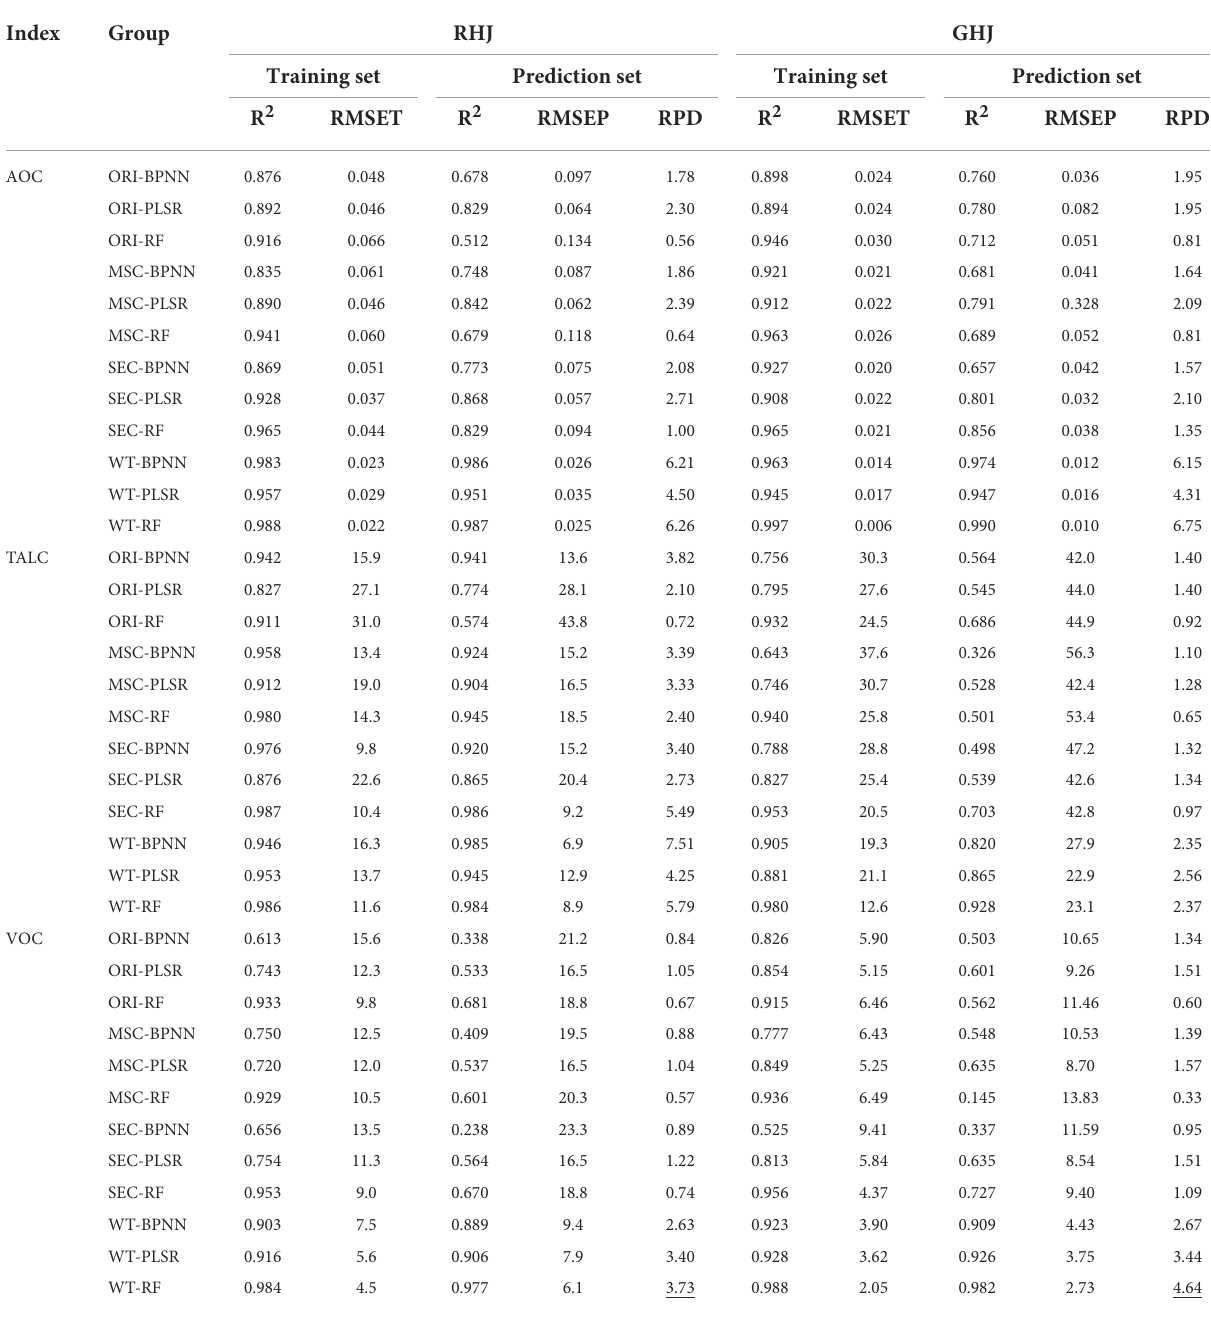
TABLE 2 Three chemical indicators prediction based on the full